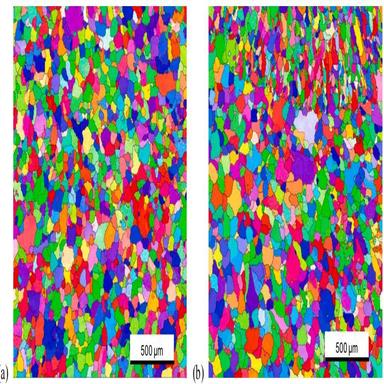
IPF mappings at two locations: (a) XY plane, and (b) in YZ plane.